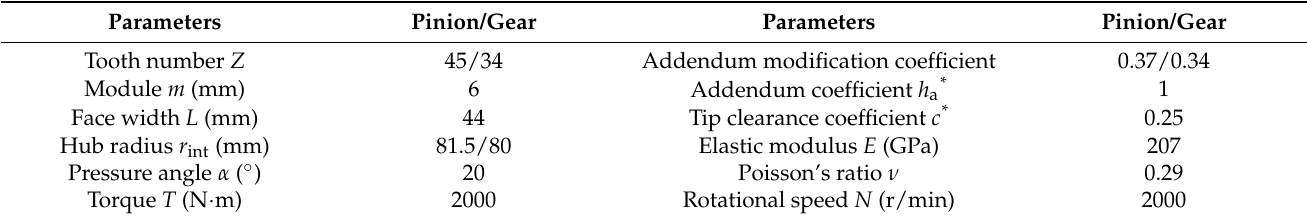
Table 1. Main parameters of the gear